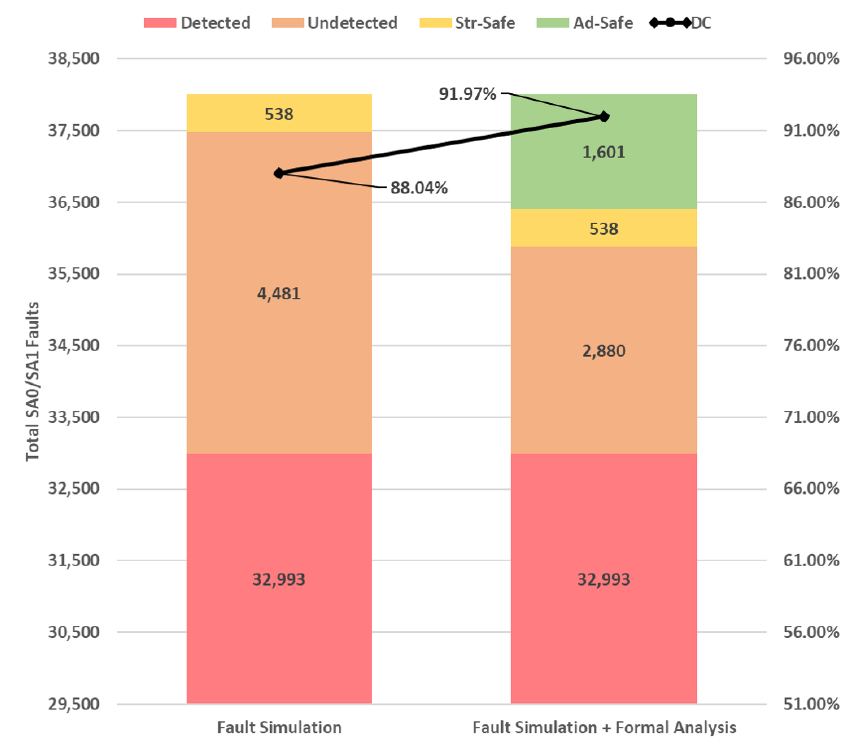
Figure 11. Combined results in CAN: uptrend in DC when fault simulation and formal analysis